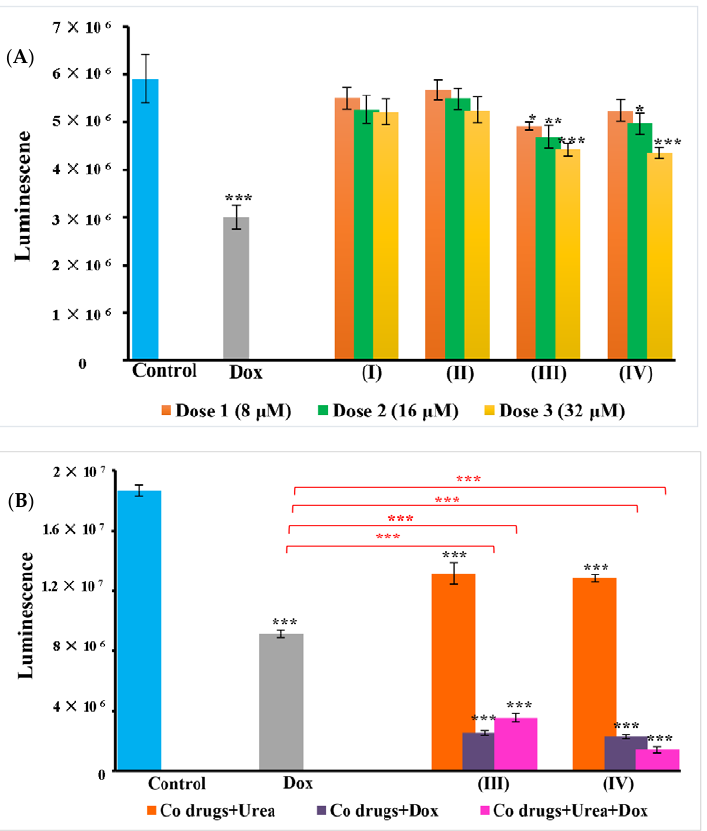
Figure 4. ATP metabolism in A549 cells. ( A ) The cellular metabolism was accessed with the ATP levels in the control (untreated) and cells treated with different concentrations (8 µ M, 16 µ M, and 32 µ M) of the cobalt complexes. ( B ) Standardized doses of complex (32 µ M) combination with urea (2 mM) and doxorubicin (50 nM). The cytotoxic ability is evident in the figure with decreased levels of ATP in cobalt (III) complexes treated groups. As seen in the figure, complexes combination with urea and doxorubicin profound decrease in ATP. ( A , B ) clearly depict the difference in the action of cobalt complexes alone and in combination with doxorubicin and urea. Here, the cytotoxic activity and decrease in ATP levels of complexes ( III and IV ) treated groups signify their ability to boost the action of doxorubicin against A549 cells. The data represent the mean ± SEM. Results are significantly different at * p < 0.05, ** p < 0.01 and *** p < 0.001 when compared to control and doxorubicin.